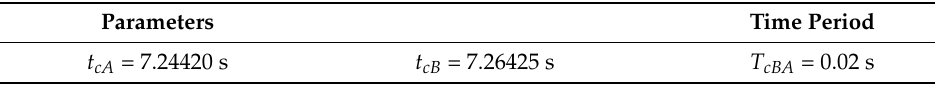
Table 5. Time period and its parameters according to Figure 20.